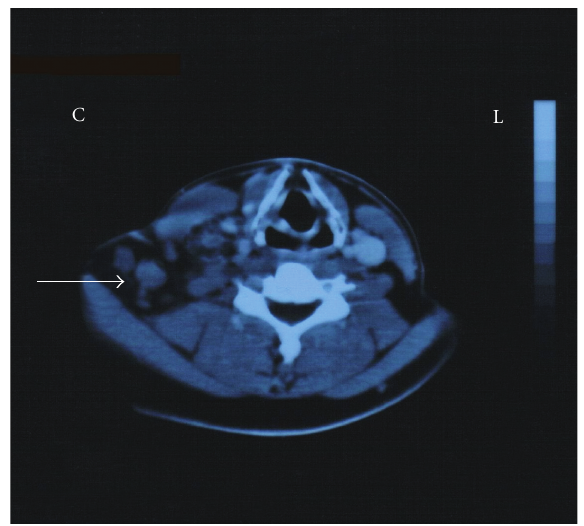
Figure 1: Enlarged supraclavicular node. Figure 2: Axial enhanced CT-image of paratracheal right-sided mass and pleural e ff